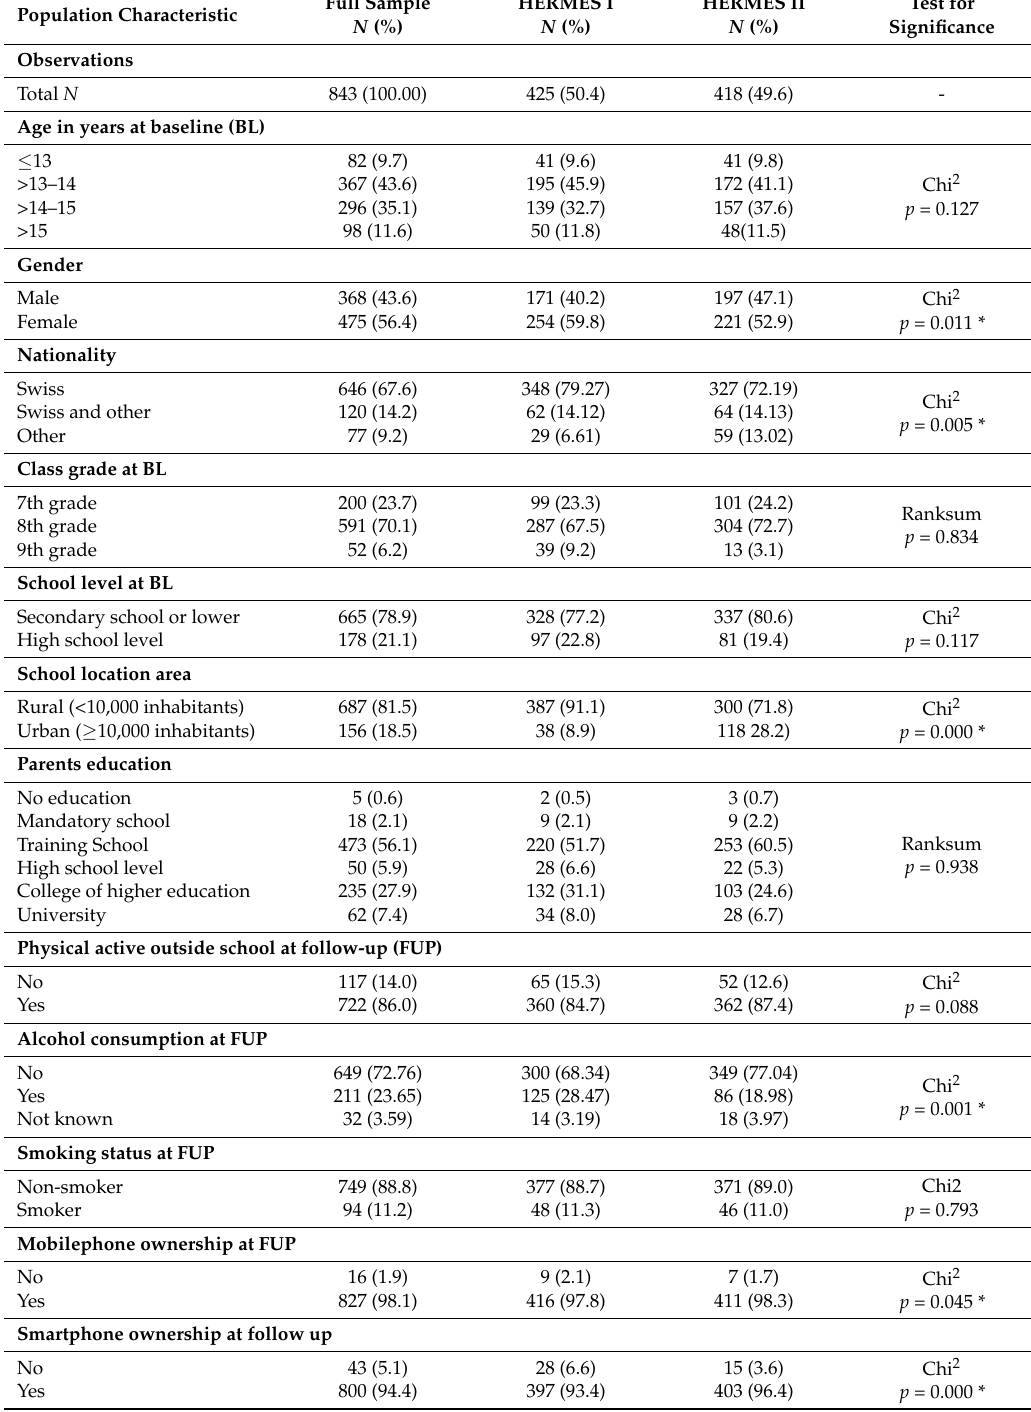
Table 1. Descriptive statistics of population characteristics of the HERMES (Health Effects Related to Mobile phone usE in adolescentS) cohort. Significance tests relate to differences in between categories of the respective variables and not among the HERMES I and HERMES II